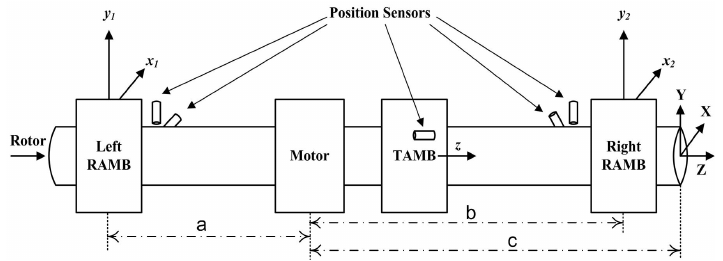
Figure 1. The layout of the rotor system by 5-DOF active magnetic suspension. The individual RAMB is electrically constructed using four coils that are installed on the stators at its right, left, lower, and upper positions. These coils are energized using DC currents that generates attractive electromagnetic forces to neutralize the rotor